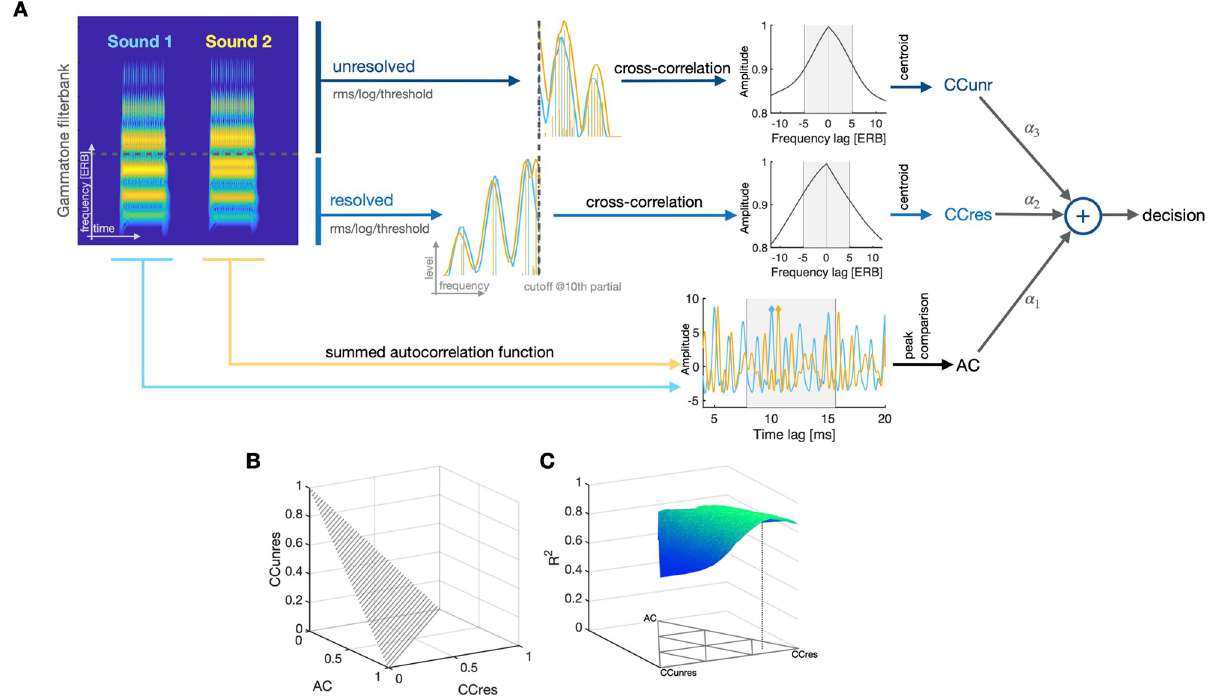
Fig 5. (A) Schematic of cue computation and integration, illustrated with a pair of harmonic sounds shifted by 11 and 1 st along the SFS and SE dimension, respectively. For the AC cue, autocorrelations within each auditory band are computed and subsequently summed across bands. From the resulting summed autocorrelation function, peaks are extracted from a search range corresponding to 64–128 Hz (gray patch) and subtracted, yielding an estimate of the periodicity difference of the two sounds; positive differences indicate downward movement. CC cues are computed using the rms- energy of bands across time, followed by a logarithm (conversion to level-domain) and thresholding below -30 dB peak level. The CCres cue considers the presumably resolved part of the excitation pattern below 905 Hz (geometric mean of the frequency of the 10th partial component across Exps. 1 and 2); the CCunres cue considers the unresolved part above that frequency limit. For both types of cues, the remaining excitation patterns are cross- correlated and the centroid (first moment) is computed in a search range (gray patches). Positive centroids indicate downward movement. Cues are integrated in a weighted sum (positive sum coded as “down”). (B) Possible cue weightings of sum one. (C) Cue weights projected onto x-y plane; the farther a point’s distance to a specific edge, the less weight the respective cue receives. The corresponding model fit is displayed on z-axis for one human listener’s results in the inharmonic SFS-EN condition. The dashed line shows the optimal weights for this